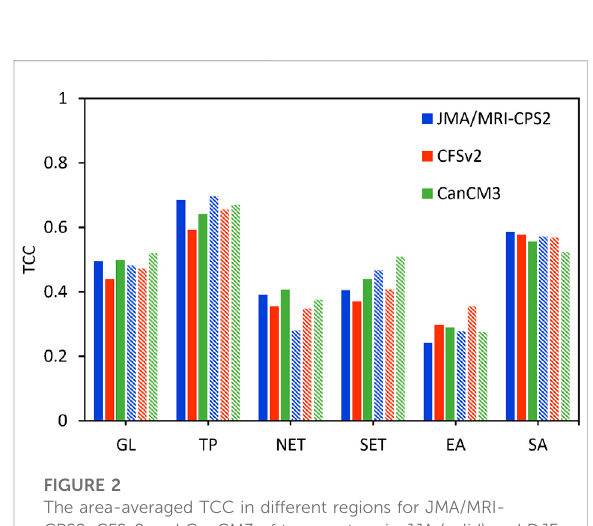
FIGURE 2 The area-averaged TCC in different regions for JMA/MRI- CPS2, CFSv2 and CanCM3 of temperature in JJA (solid) and DJF (shaded) season for the period 1982 –